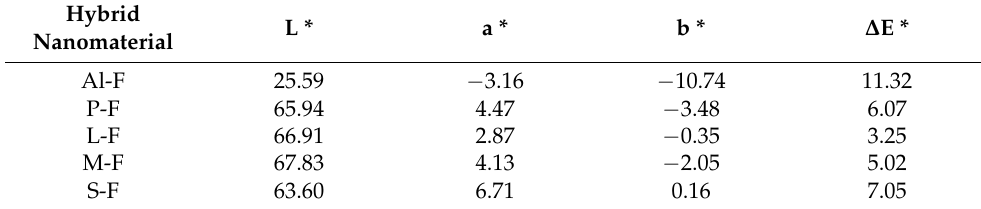
Table 4. Colorimetric parameters of the hybrid nanomaterials.